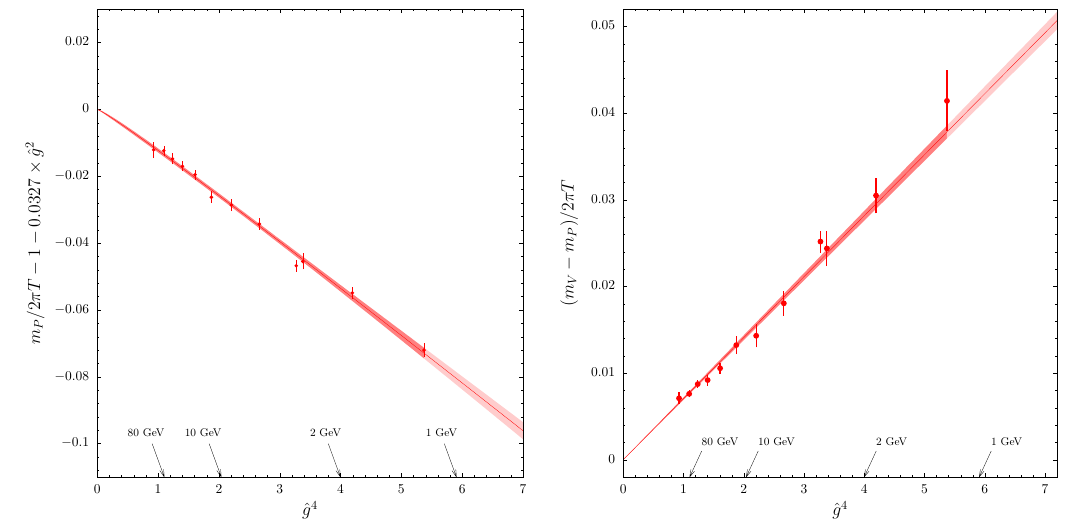
Figure 4 . Left: the pseudoscalar mass, normalized to 2 πT , subtracted of the analytically known contributions versus ˆ g 4 . Right: the vector-pseudoscalar mass difference, normalized to 2 πT , versus ˆ g 4 . Red bands represent the best fits of the data as explained in the